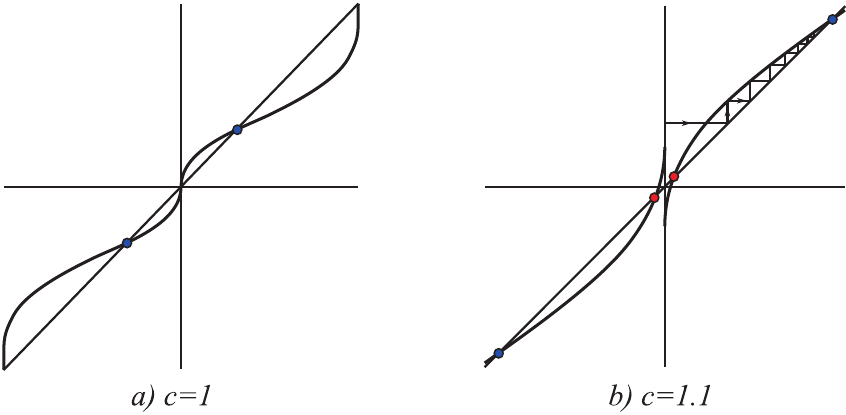
Fig. 7 The second iteration of the map T c , ε for ε = 0 . 7 with c = 1 (fig. a) and c = 1 . 1 (fig.b). In fig. b, a magnified fragment near the discontinuity point is